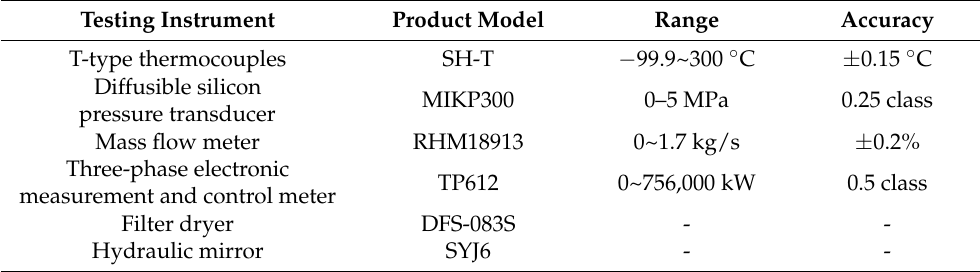
Table 1. Experimental instrument